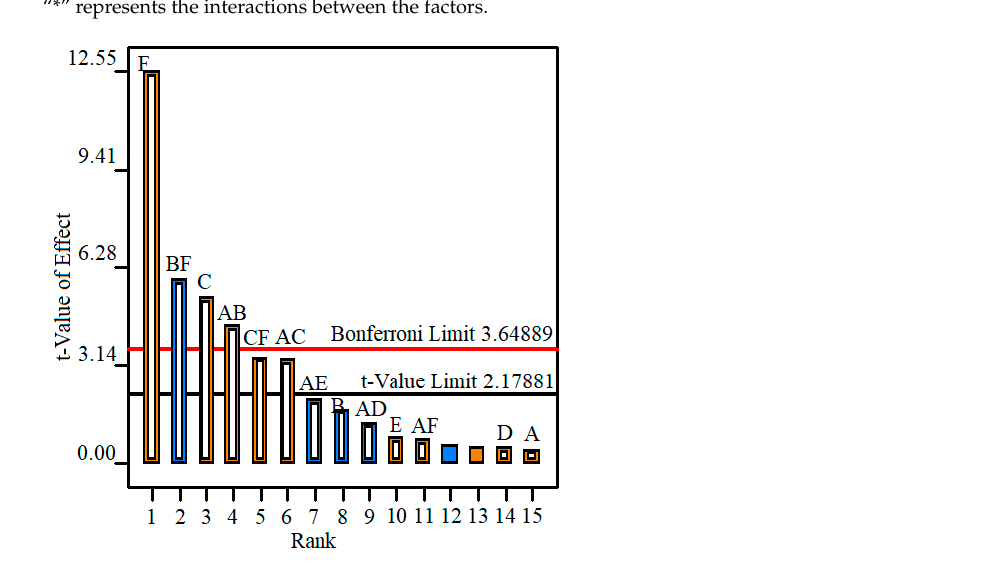
Figure 4. Pareto chart of the effects of the input variables on surface roughness (A—fluid type; B— Figure 4. Paretochartoftheeffectsoftheinputvariablesonsurfaceroughness(A—fluidtype; B—lubrication lubrication methods; C—nanoparticle type; D—nanoparticle concentration; E—cutting speed; F— feed rate).